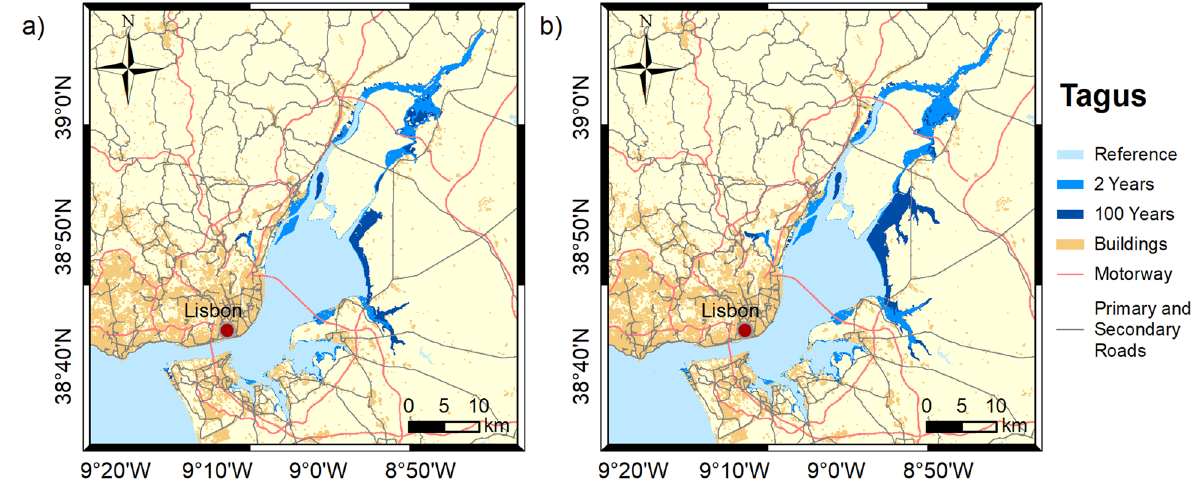
Figure 5. Inundation extents induced by extreme sea levels with return periods of 2 and 100 years on the Tagus estuary in: ( a ) 2046–2065; and ( b ) 2081–2100. These maps were created with Esri ArcGIS 10.8 software (https:// www. esri. com/ en- us/ home).